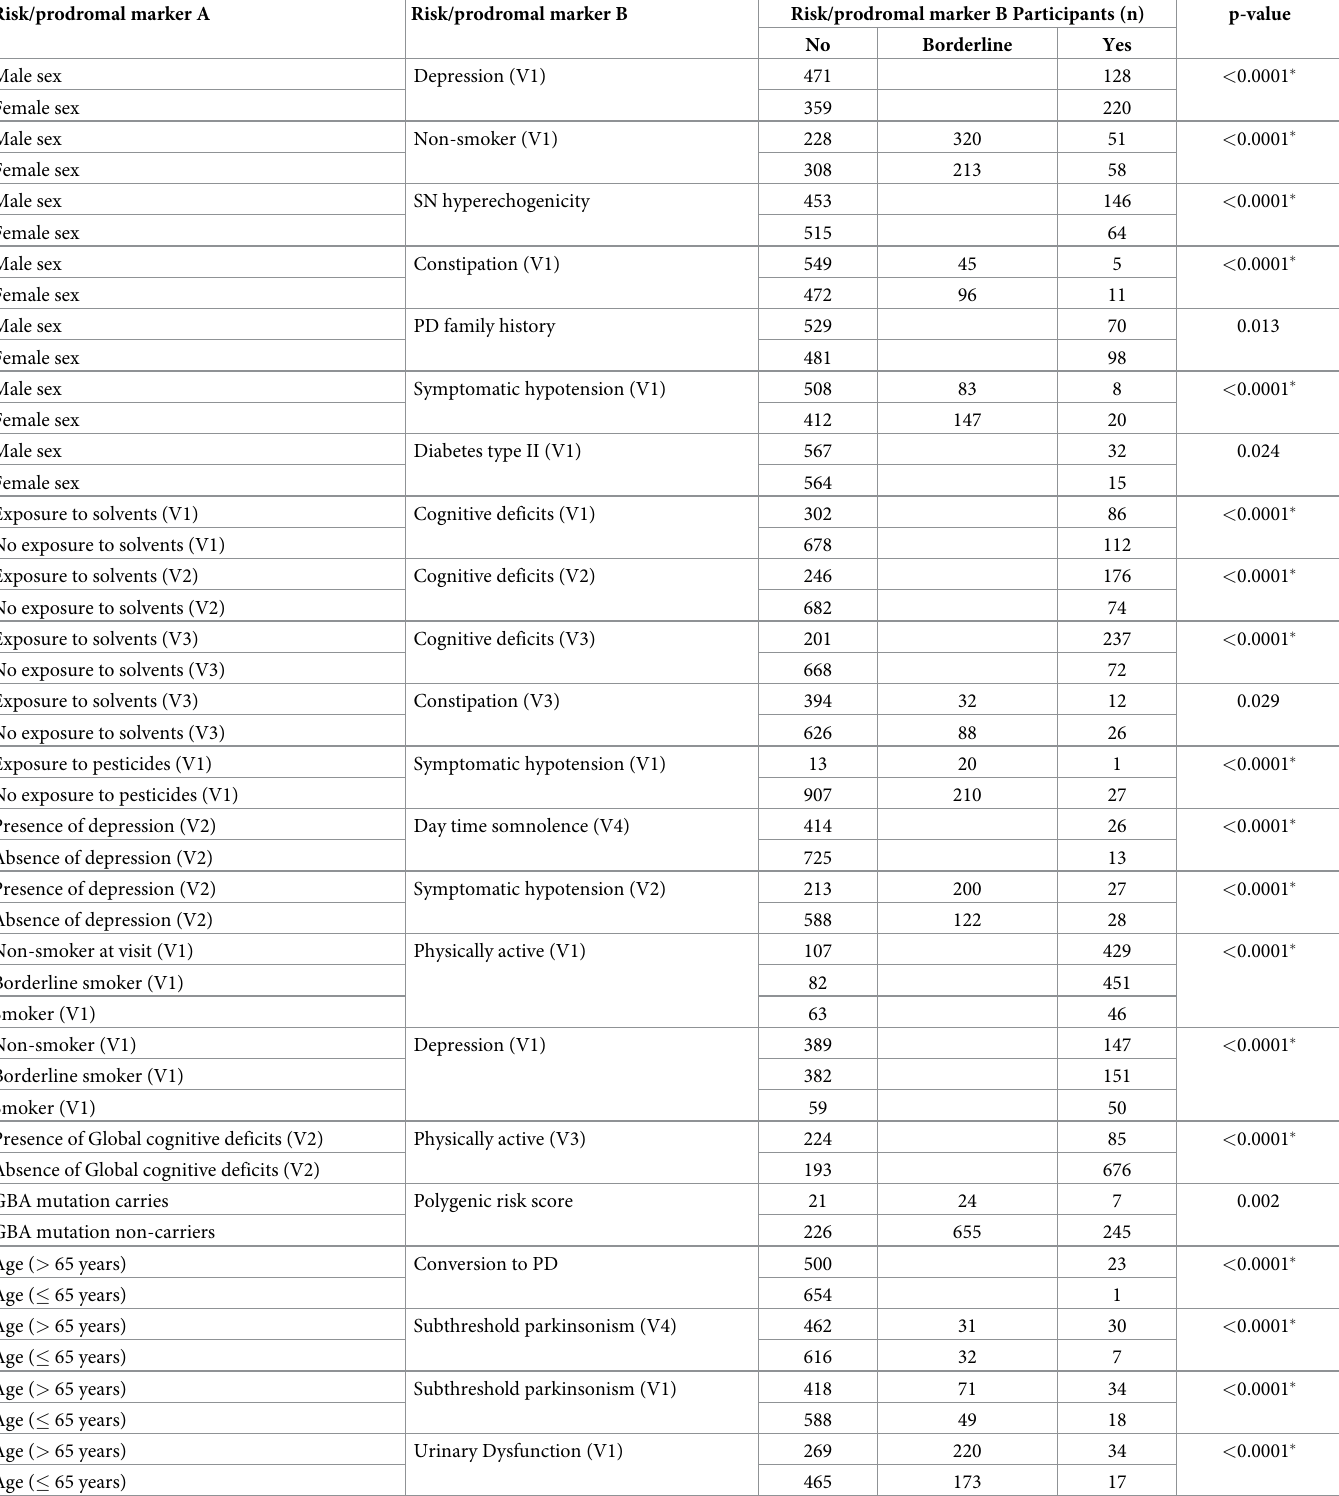
Table 3. Co-occurrence of